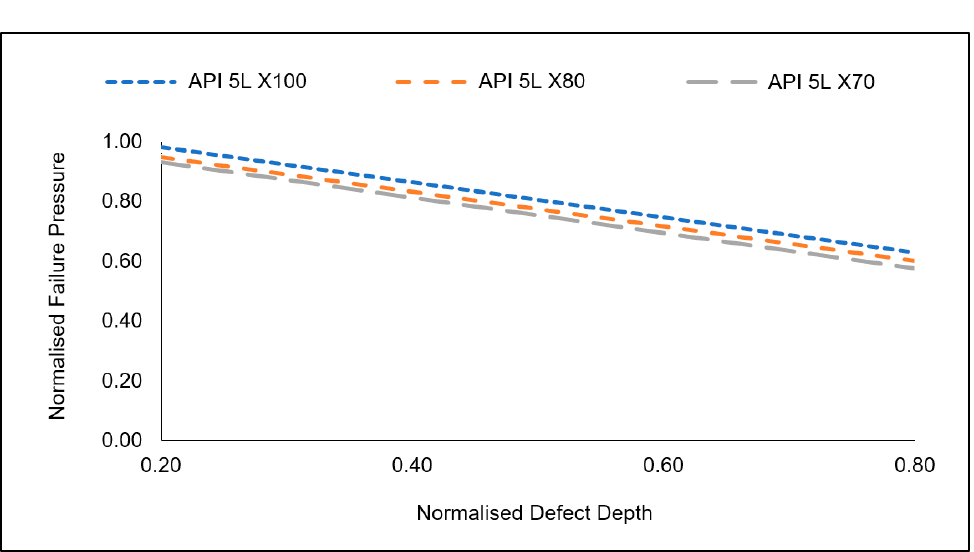
Figure 8. Normalised failure pressure of a corroded pipe elbow with a single defect of normalised defect length of 0.2 and subjected to a normalised axial compressive stress of 0.2. defect length of 0.2 and subjected to a normalised axial compressive stress of